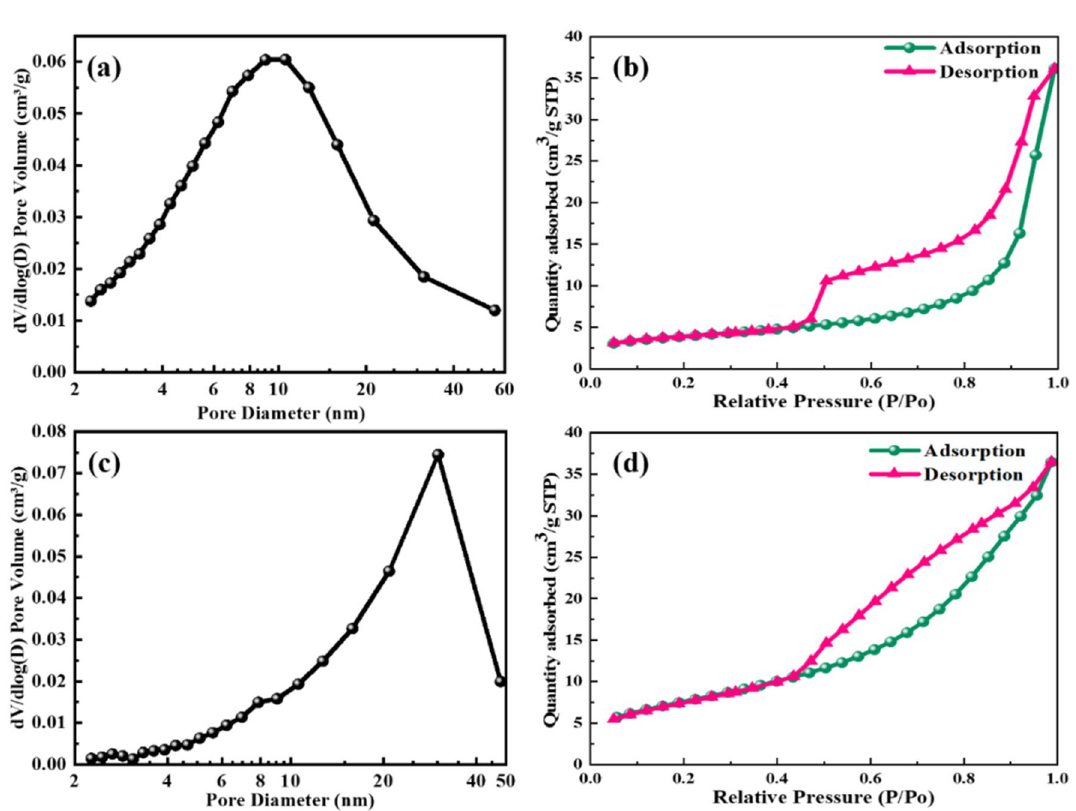
Figure 11. ( a ) The pore size distributions of GEO; ( b ) The Nitrogen adsorption–desorption isotherms of GEO; ( c ) The pore size distributions of ZEO; ( d ) The Nitrogen adsorption–desorption isotherms of